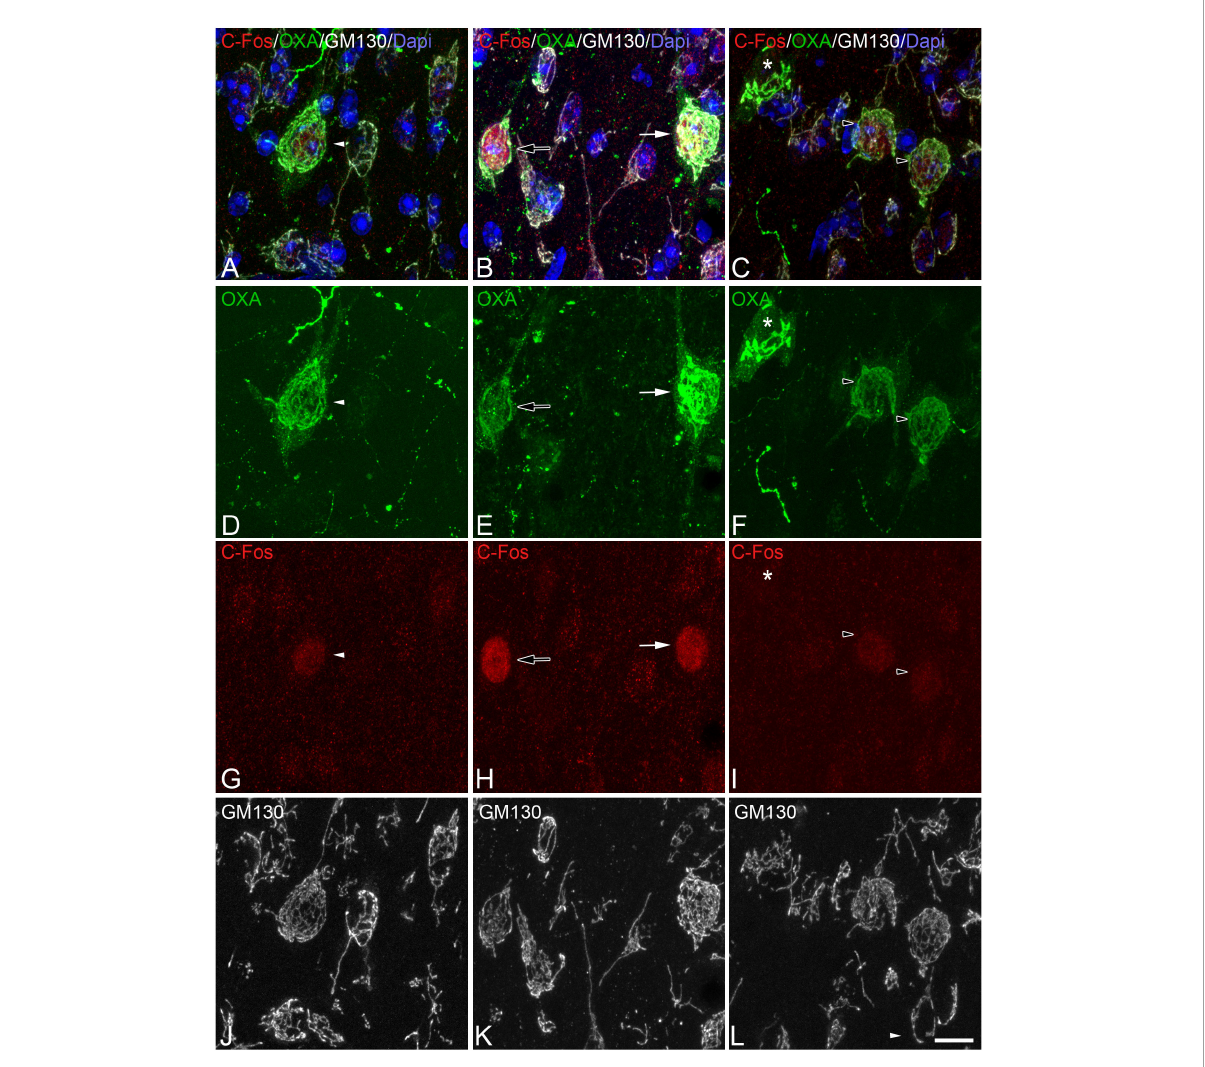
FIGURE4 (A-D-G-J, B-E-H-K, C-F-I-L) Groups of confocal projection images taken from OXA/C-Fos/GM130 triple-immunostained sections and counterstained with DAPI, showing examples of LH orexinergic neurons, from euthermic Syrian hamsters, with different patterns of immunostaining. Note the presence of orexinergic neurons with intense OXA immunostaining showing intense [solid arrows in panels (B,E,H) ] or moderate [solid arrowheads in panels (A,D,G) ] C-Fos expression—or with no C-Fos immunostaining [asterisks in panels (C,F,I) ]. Note also the presence of orexinergic neurons with moderate OXA immunostaining and intense [hollow arrows in panels (B,E,H) ] or moderate [hollow arrowheads in panels (C,F,I) ] C-Fos expression. Note also both orexinergic and non-orexinergic LH neurons in euthermic hamsters showing normal patterns (see text) of the GA, as revealed by GM130 immunostaining. Scale bar shown in panel (L) indicates 10.5 µ m.